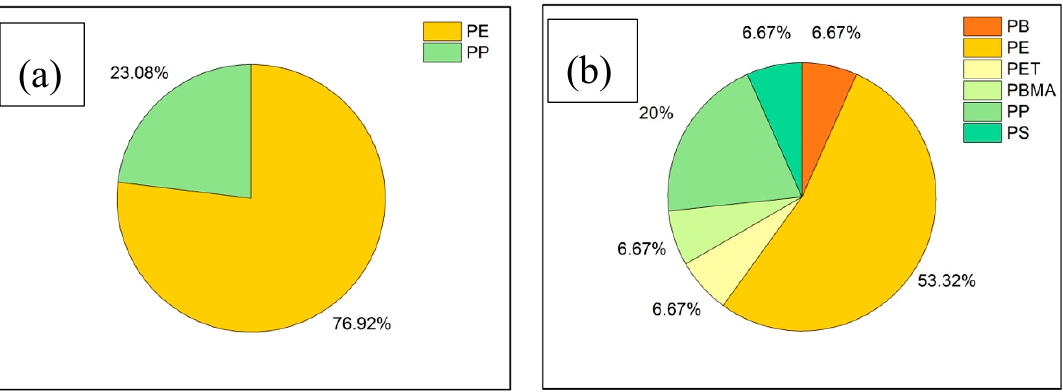
Figure 5. Chemical distribution of microplastics in ( a ) the water column (H) and ( b ) at the outlet of the lake (O).